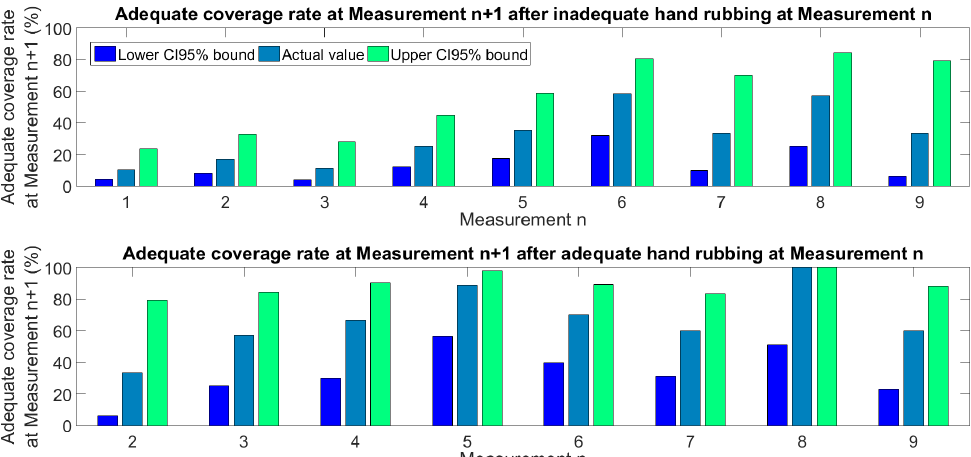
Figure 5. Statistics of consecutive measurements using 1.5 mL ABHR. The upper graph shows the adequate coverage rate at Measurement n + 1, occurring after inadequate coverage performed at Measurement n. The lower graph shows the adequate coverage rate at Measurement n + 1, occurring after adequate coverage performed at Measurement n.